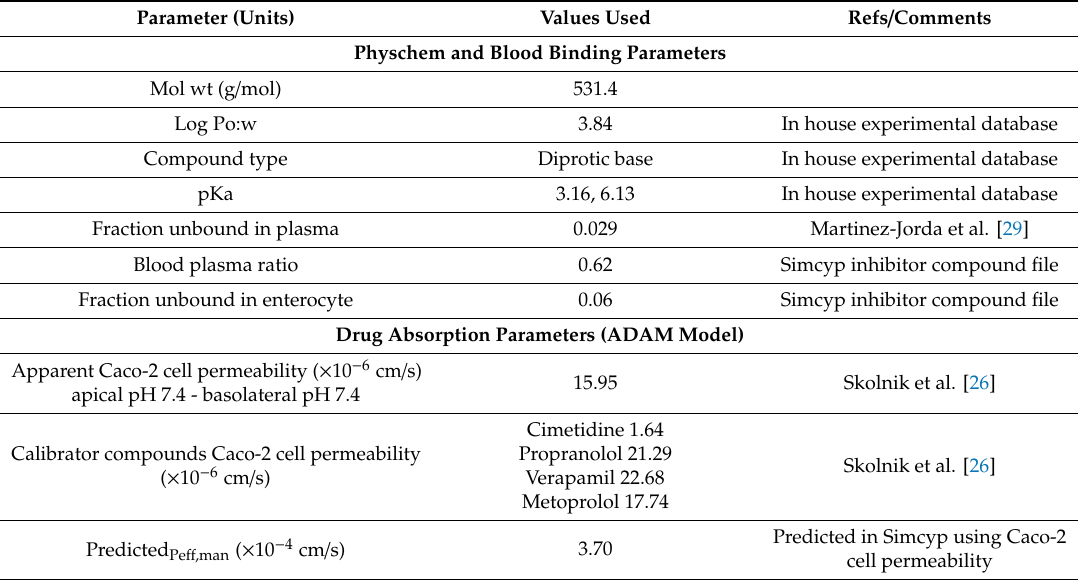
Table 2. Values of physicochemical and pharmacokinetic parameters used in PBPK models for ketoconazole in the present